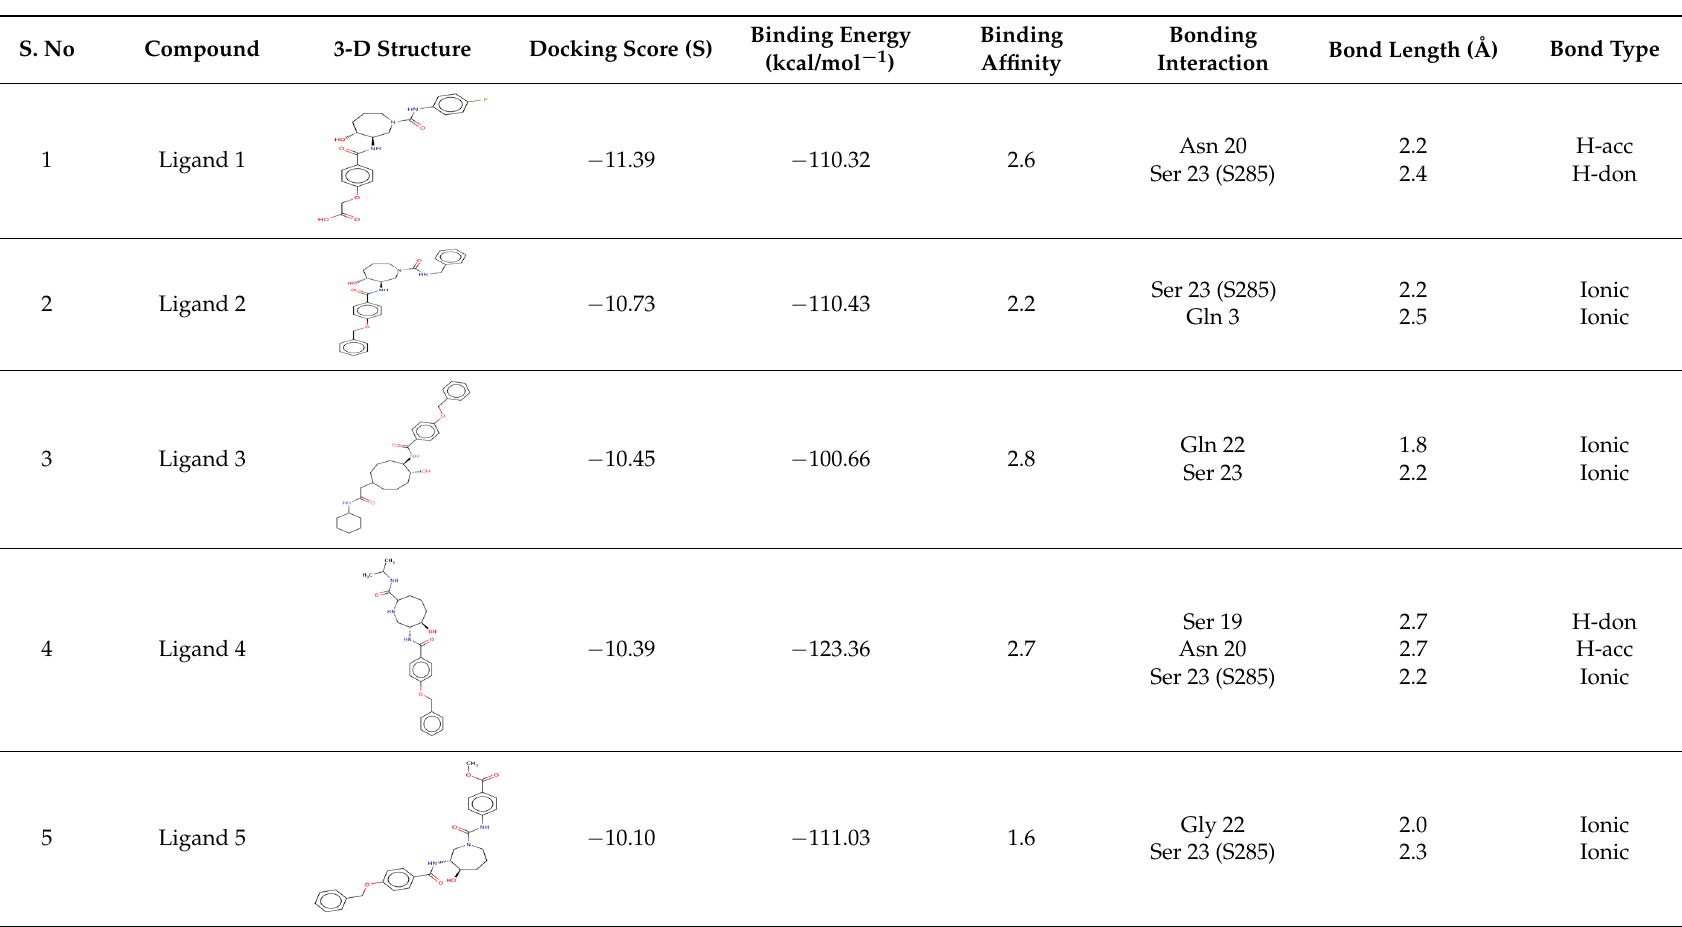
Table 4. Docking table with bonding characterization and binding energies in kcal/mol with top five therapeutic ligands involved in p-tau inhibition. S. No